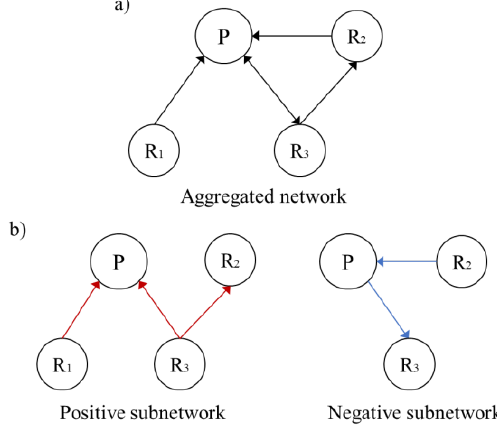
Figure 3. Corresponding networks including ( a ) an aggregated network and ( b ) positive and negative emotional contagion networks of the example in Figure 1.